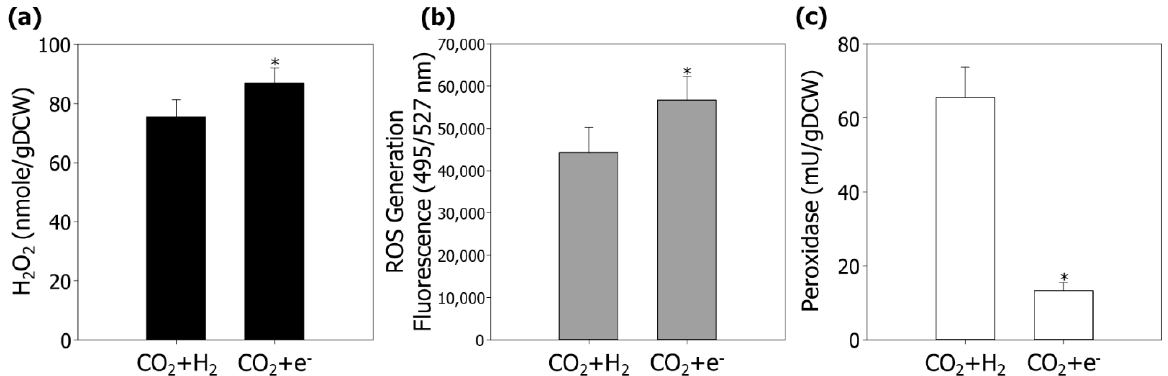
Figure 2. Endogenous levels of ROS in R. sphaeroides under photoautotrophic (CO 2 + H 2 ) and MES (CO 2 + e − ) conditions. ( a ) Endogenous contents of H 2 O 2 . ( b ) Generation of endogenous ROS. The levels of ROS were measured using CM ‐ H 2 DCFDA. The fluorescence is represented in arbitrary units and normalized by the optical density of the samples. ( c ) The measurement of peroxidase activity. Experiments were conducted in triplicate and error bars indicate standard deviation of mean. Asterisk represent statistically significant difference, as determined by a Student’s t ‐ test (* p < 0.05).